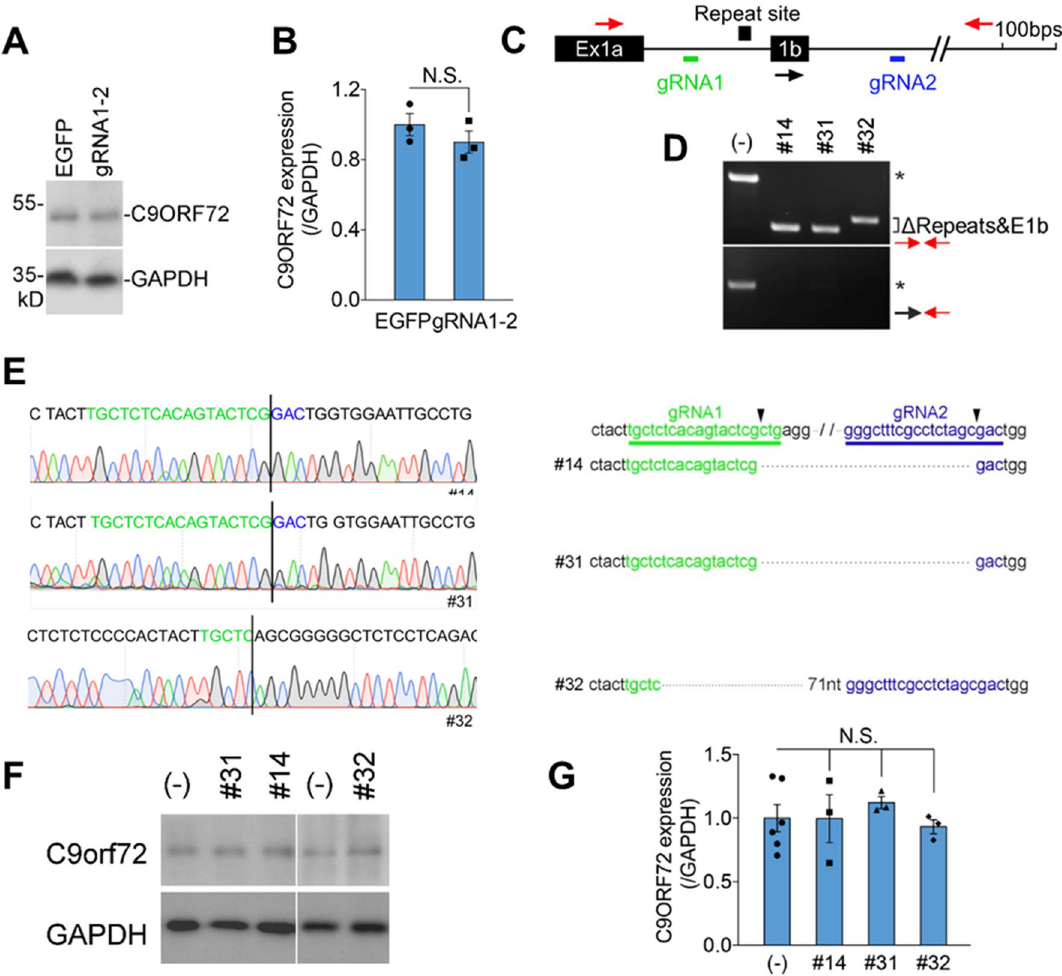
Figure 3. Deletion of repeat site and exon 1b by gRNA1-2 has limited effect on C9ORF72 protein expression. ( A ) Representative image of C9ORF72 immunoblot from HEK293 cells constitutively expressing Cas9 and infected with control (EGFP) or gRNA1-2 lentiviral particles. GAPDH served as loading control. ( B ) Relative expression level of C9ORF72 protein (normalized to GAPDH) shown in ( A ). Protein lysates from three independent infections. ( C ) The genome structure of C9ORF72 exon 1a (Ex1a) and exon 1b (1b) and locations of gRNA1 and gRNA2. Primers used for screening for HEK293 single cell clones with repeat site and 1b deletion. ( D ) Identification of single cell clones with deletion of the repeat site and 1b (ΔRepeats + E1b) by gRNA1-2. Asterisk indicated the normal PCR bands that appeared in non-editing control (-). Upper panel, primers flanking the repeat site and exon 1b detected smaller bands (ΔRepeats + E1b) in three single cell clones (#14, 31, and 32), however, the normal PCR band (*) did not appear in these lines. Lower panel, PCR band with exon 1b (*) appeared in non-editing control (-) but not in these single cell clones. PCR condition in upper panel, with high GC buffer. ( E ) The smaller bands (ΔRepeats + E1b) shown in ( D ) were applied for Sanger sequencing (Left). Sequence alignment represents the exact deletions in these three single cell clones (Right). The conventional SpCas9 cleavage sites (3 neucleotides upstream of PAM) of gRNA1 and gRNA2 were labeled (black arrow head). ( F ) Representative images of C9ORF72 immunoblot from the control (-) and #14, 31, and 32 single cell clones. ( G ) Statistical analysis of C9ORF72 relative expression level shown in ( F ). The protein lysates from at least three biological replicates. In ( B ) and ( G ), the values are presented as mean ± SEM ( n ≥ 3). N.S., no statistical significance (t-test or ANOVA,